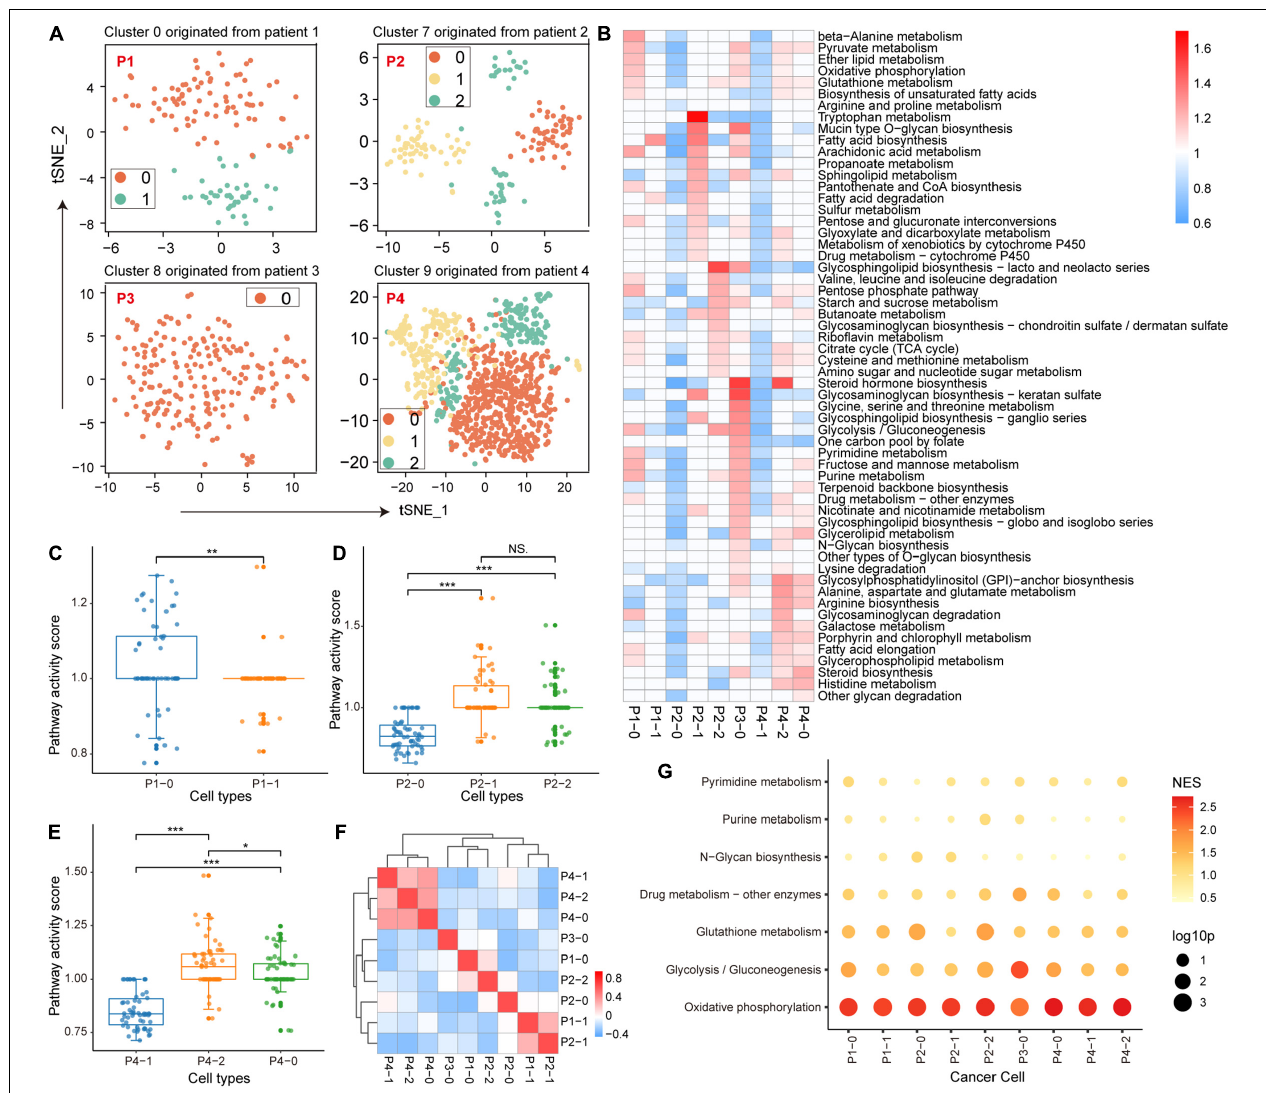
FIGURE 2 | Metabolic features of malignant epithelial cells. (A) Four clusters of malignant epithelial cells originating from four patients with non-small cell lung cancer (NSCLC) were individually re-clustered using t-SNE. (B) Metabolic pathway activity in each cell cluster. Values with statistically non-significant pathway activity (random permutation test, p > 0.05) were shown as blank. (C–E) Boxplot of pathway activity scores of malignant cell clusters originating from patients 1, 2, and 4. (F) Correlation of each malignant cell cluster in metabolic pathway activity scores. Additionally, ∗ p < 0.05, ∗∗ p < 0.01, ∗∗∗ p < 0.001. (G) Enrichment results of metabolic pathways in variant genes using gene set enrichment analysis (GSEA). The size of the bubbles represents statistical significance and the shade of the color represents the normalized enrichment score